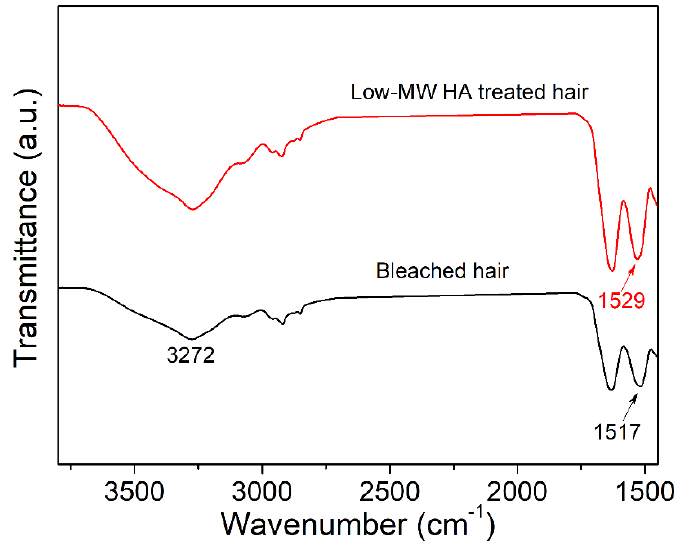
Figure 4. FT-IR spectra of the bleached hair and low-MW HA-treated hair.